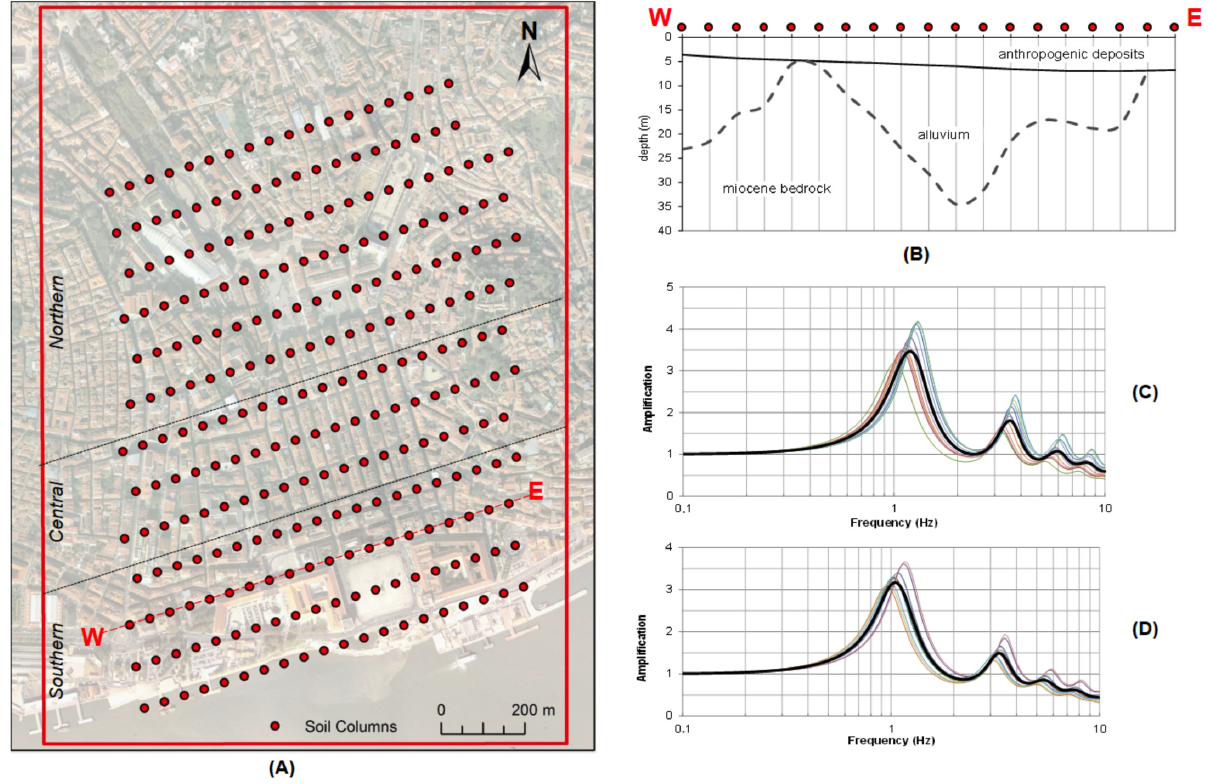
Figure 13. Location of the 256 soil profiles for which the transfer functions were computed (A). Example of one cross section performed to define the soil profiles (B). Transfer functions computed for 10 near-field (C) and 10 far-field (D) seismic motions for an arbitrary profile. The black bold curves are the mean transfer functions for each type of